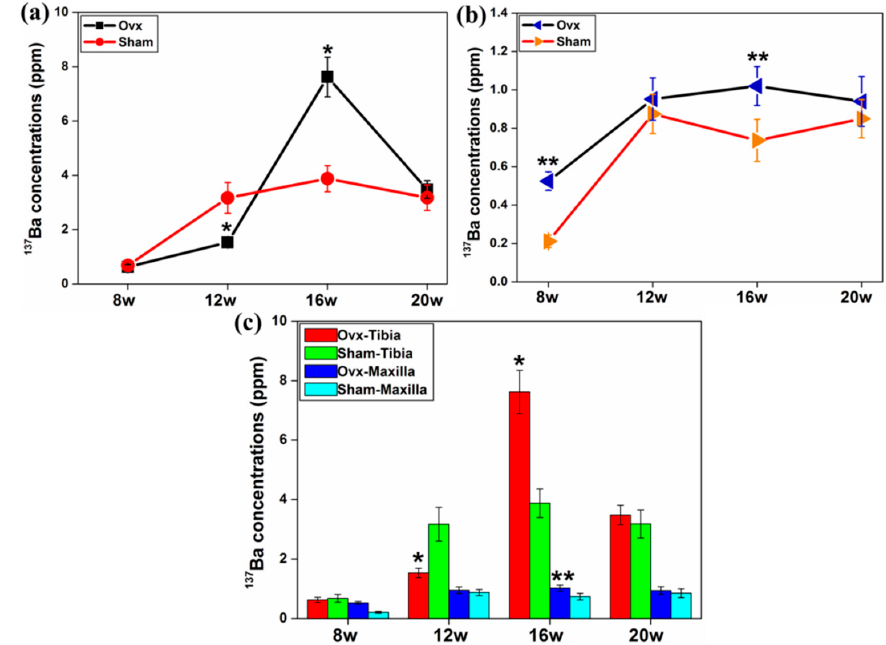
Figure 6. ( a ) The effect of Ovx on the concentrations of 137 Ba in tibia and ( b ) maxilla at different time points post-surgery. Ovx increased the concentration of 137 Ba in maxilla across all the time points; and ( c ) higher concentration of 137 Ba was detected in tibia than in maxilla, peaking at week 16. *: Significant difference ( p < 0.05) between Ovx-tibia and Sham-tibia; **: Significant difference ( p < 0.05) between Ovx-maxilla and Sham-maxilla.